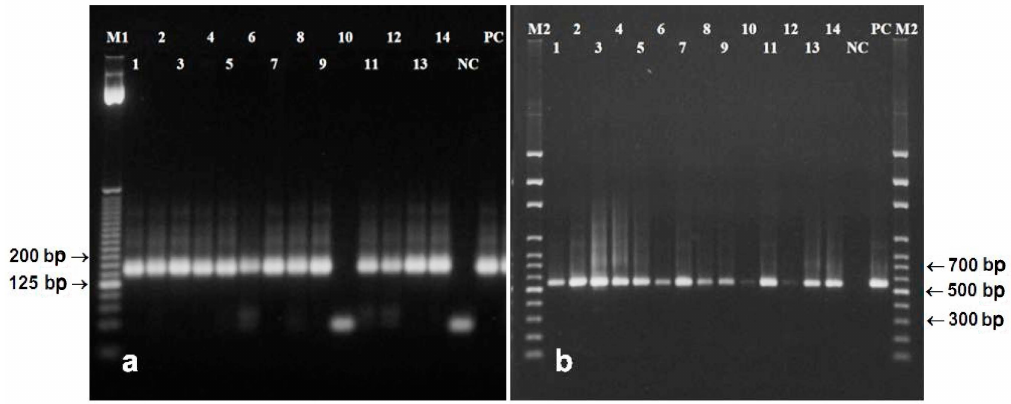
Figure 2. Amplification of 156 bp microsatellite psSSR69 ( a ) and 553 bp fragment of gene for tubulin beta-7 chain ( b ) in DNA extracted from poppy seeds by: Dellaporta et al. [24] with and without liquid N 2 (lanes 1 and 2), Dellaporta et al. [24] with CTAB with and without liquid N 2 (lanes 3 and 4), Bayer BioScience N.V. [25] (5), Murray, Thompson [27] (6), Monsanto Company [26] (7), Sangwan et al. [21]